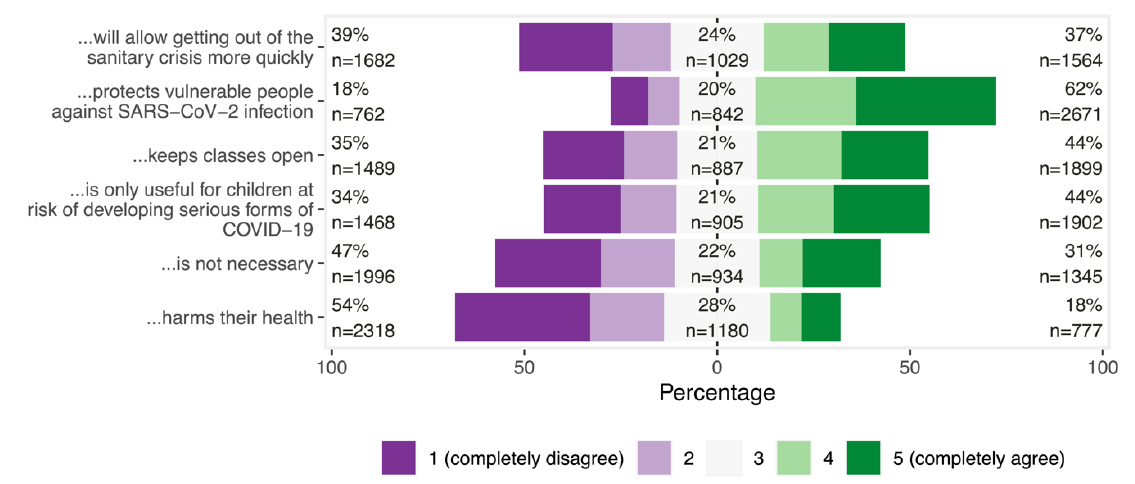
Supplementary figure 1. Opinion on vaccination of children and adolescents. On a 5-point scale, participants were asked their opinion about each statement. Percentages on the left give total completely or somewhat disagreeing with the statement (i.e. chose 1 or 2), percentages in the middle are those without an opinion in either direction (chose 3), percentages on the right are the total in partial or complete agreement with the statement (i.e. chose 4 or 5). This question was asked to all participants